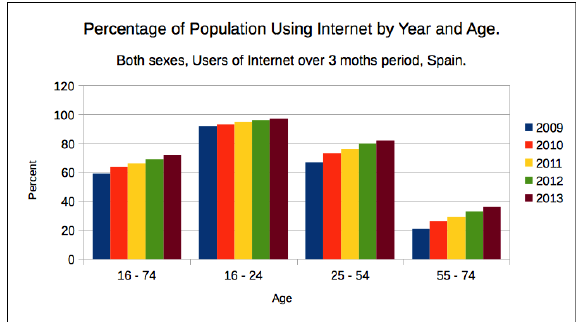
Figure 1. Percentage of Spanish population, both sexes, using Internet by year and age, over 3 moths period. First column shows total for any age within 16–74